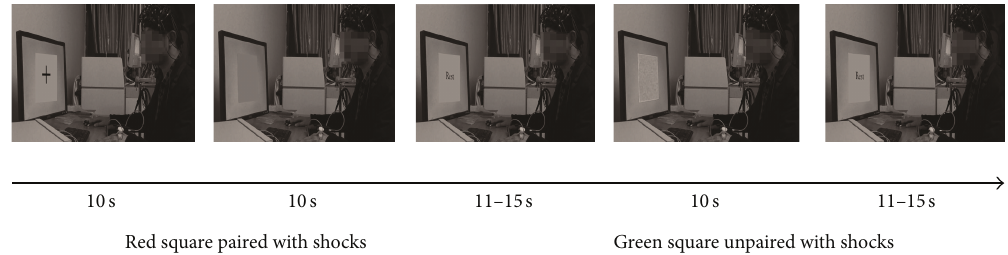
Figure 1: Experimental design. Participants watched a demonstrator responding to colored squares paired with shocks and the other type of colored squares unpaired with